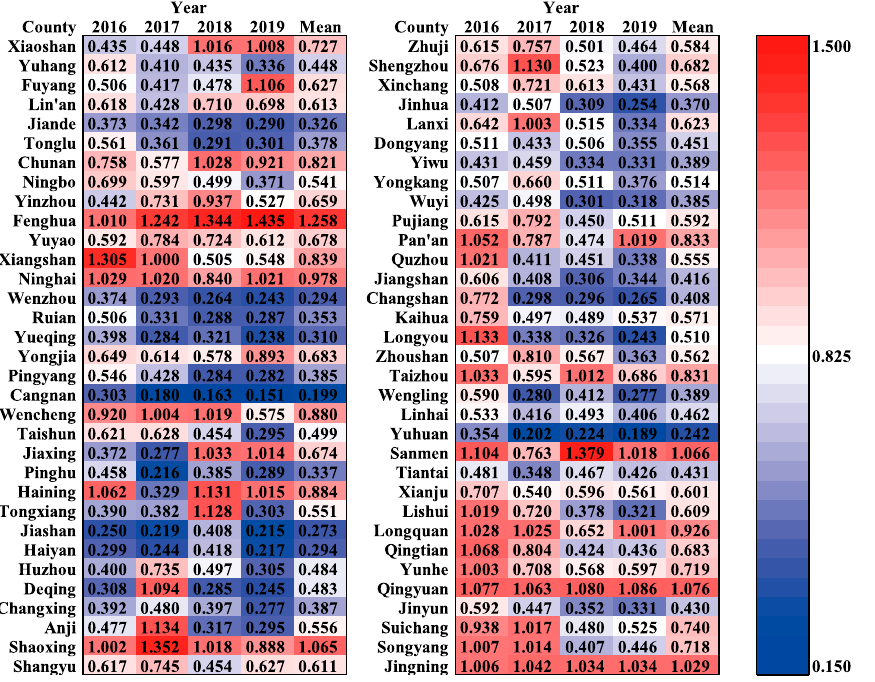
Figure 2. Forest carbon sequestration efficiency for the 66 counties in Zhejiang Province, from 2016 to 2019.